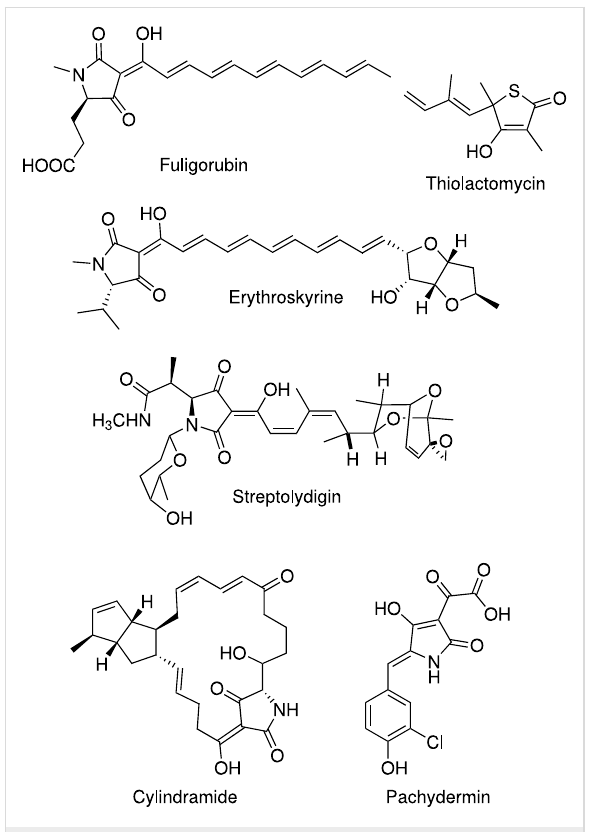
Figure 1: Tetramic acid antibiotics from natural